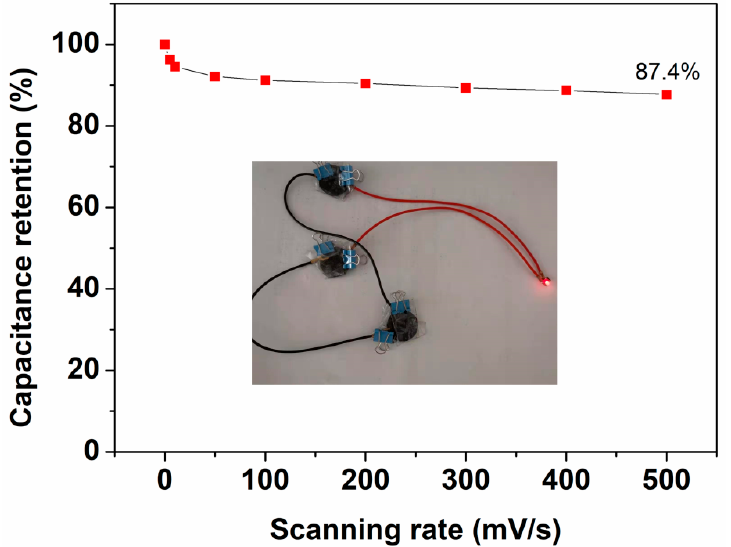
Figure 8. Rate stability of the AS and the application of powering the LED light (40 mW).